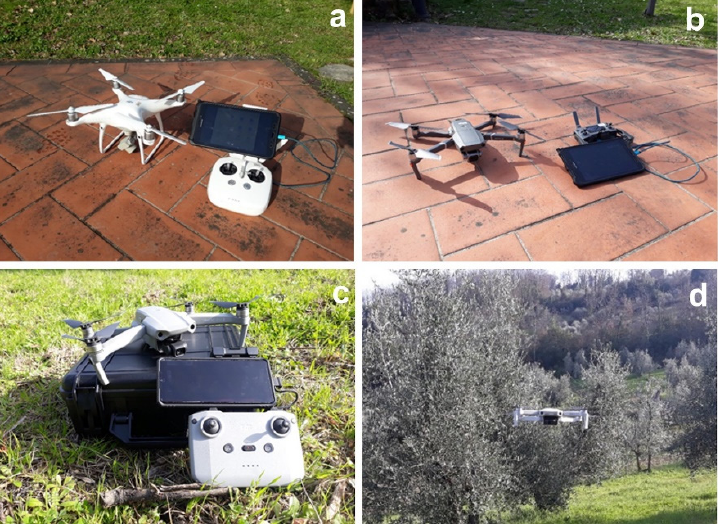
Figure 1. Used UASs: ( a ) Phantom 4 ADV; ( b ) Mavic 2 Pro; ( c ) Mavic Air 2; ( d ) Mavic Mini 2.